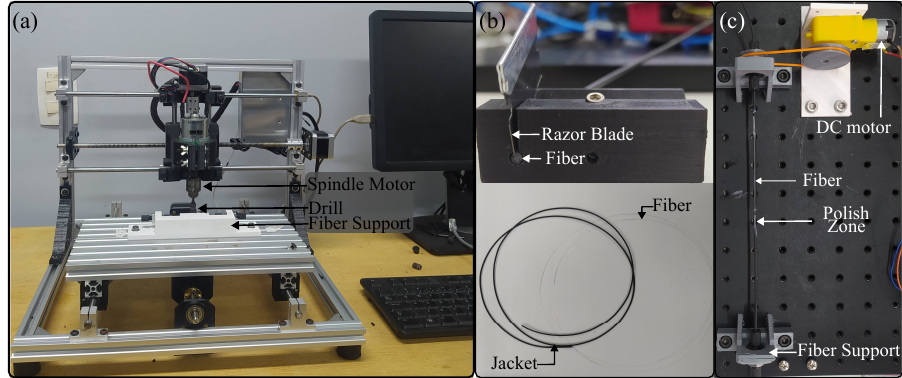
Figure 3. Devices used in the sensor’s construction. ( a ) CNC. ( b ) 3D-printed structure and fiber cladding separated from its jacket. ( c ) 3D-printed structure to obtain the polish around the